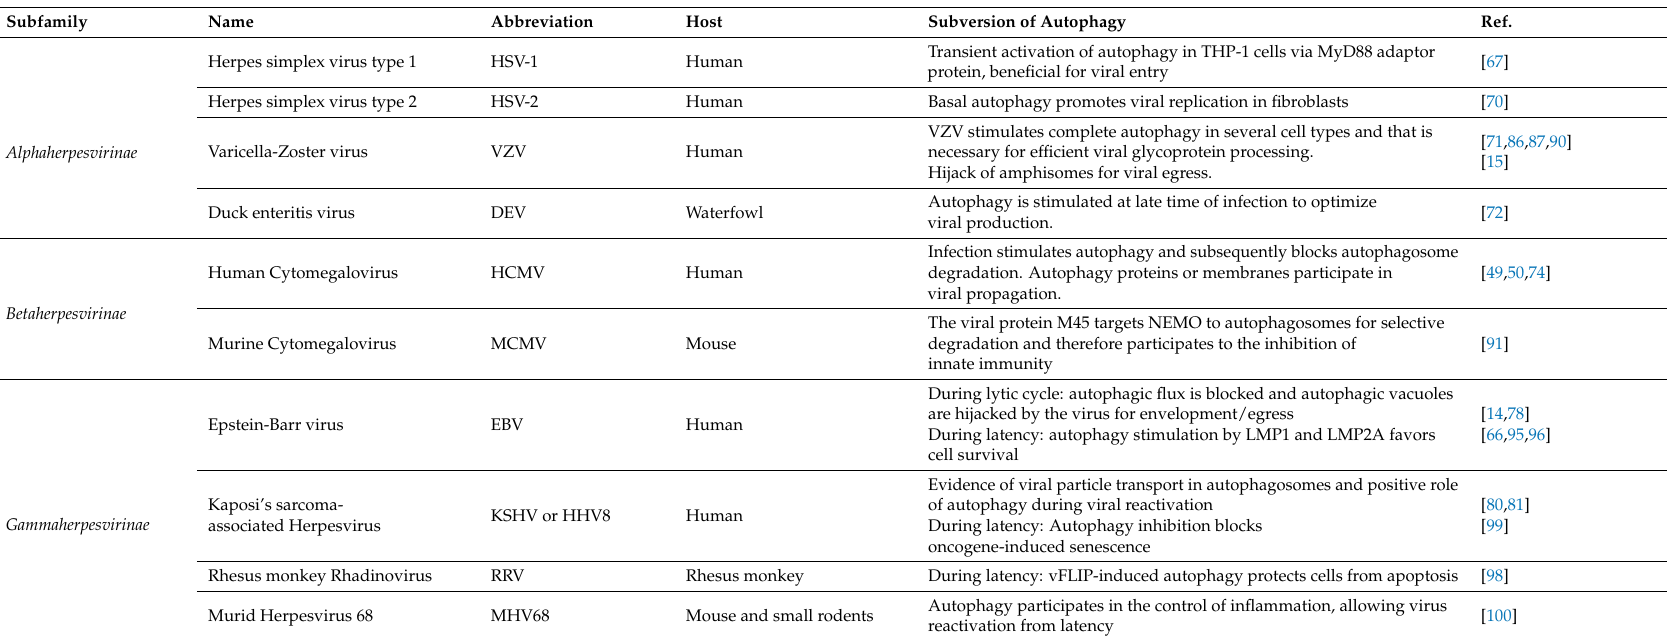
Table 1. Subversion of Autophagy by